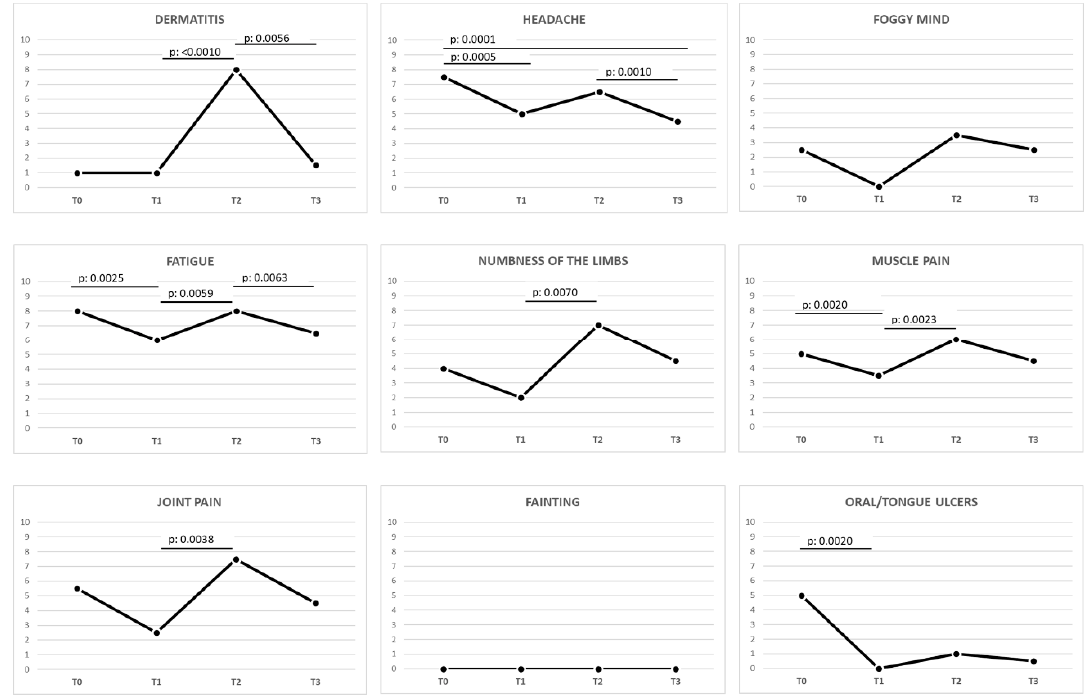
Figure 5. Variation of extraintestinal symptoms in celiac patients during di ff erent stages of the study. The p -value was calculated using the Wilcoxon signed-rank test (statistically significant p -value < 0.0083 according to Bonferroni correction). Legend: GSRS, Gastrointestinal Symptom Rating Scale; T0, baseline, during gluten-containing diet; T1, after ≥ 12 months of proper gluten-free diet; T2, after ≥ 3 months of prolonged gluten-free and nickel-rich diet; T3, after 3 months of low-nickel and gluten-free diet.